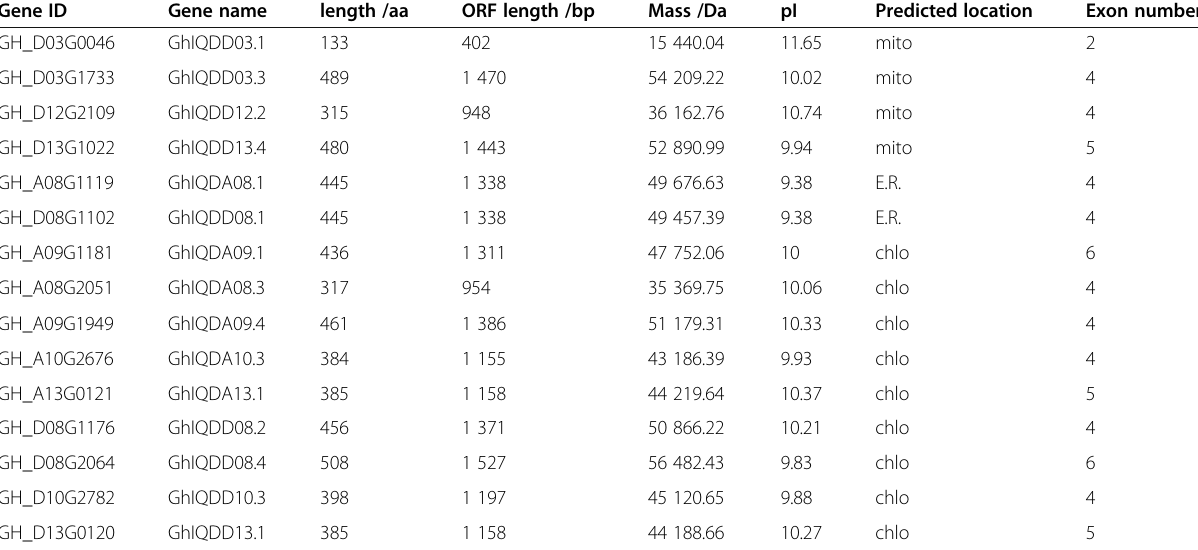
Table 1 Information of GhIQD gene family members in G.hirsutum L., their sequence characteristics and subcellular location (Continued) Gene ID